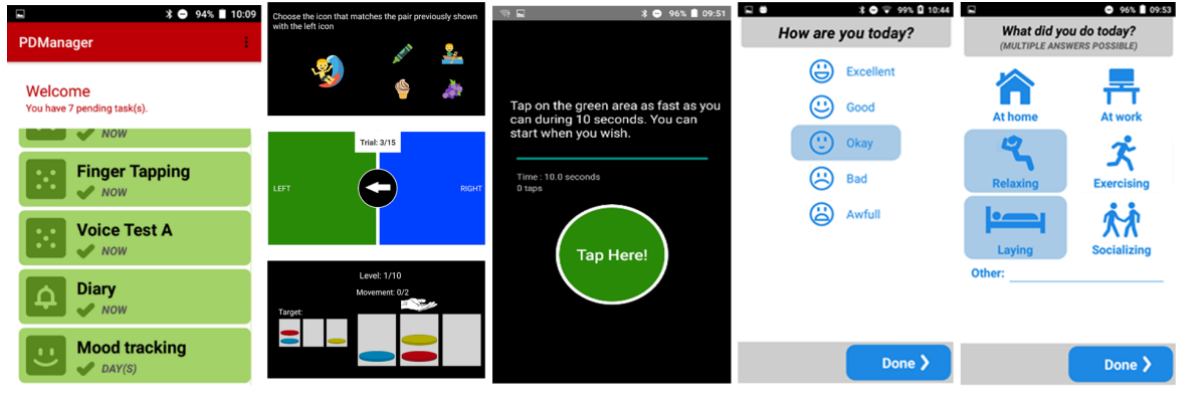
Data from devices were transferred and stored in a web-based cloud, NoSQL database in anonymized and encrypted